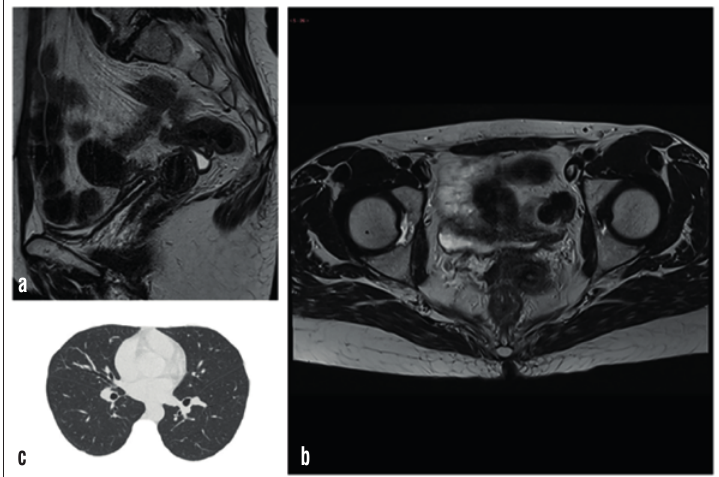
Figure 3. Follow up (February 2020): a) Sagittal and b) axial pelvic MRI scans with part of cervix - without signs of tumor recurrence, c) non-contrast axial scan of thorax after treatment -without signs of disease in lung parenchyma